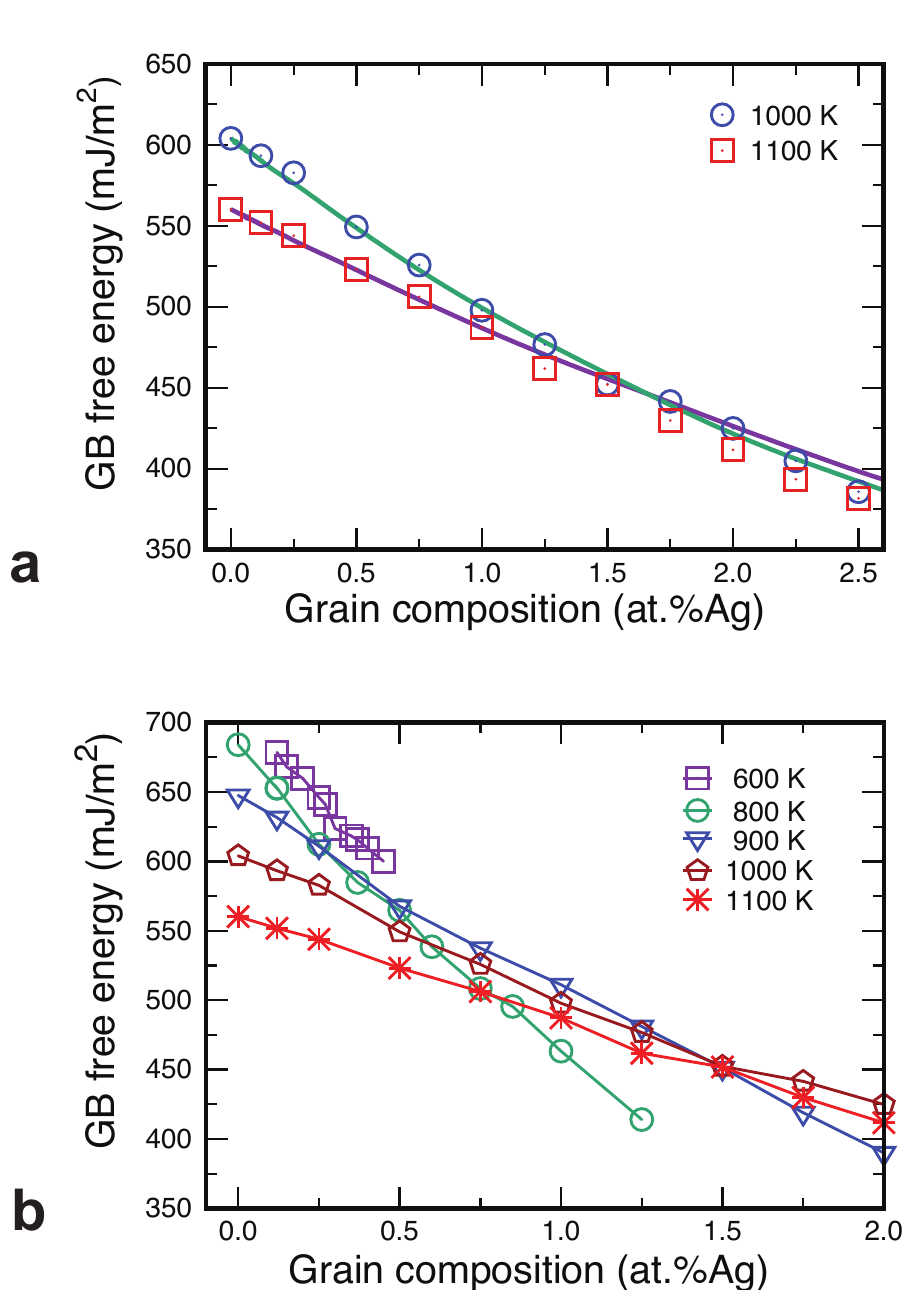
Figure 10. Composition and temperature dependencies of the equilibrium GB free energy in the Cu–Ag solid solution. ( a ) Comparison of the exact free energy obtained by thermodynamic integra- tion [54] (lines) with the dilute solution approximation by Equation (3) (points). ( b ) Calculations from Equation (3) for several temperatures and alloy